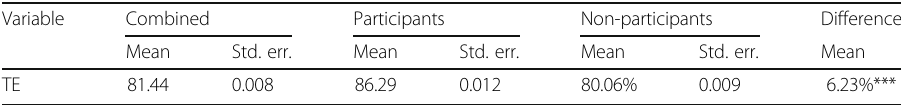
Table 6 TE scores after bias